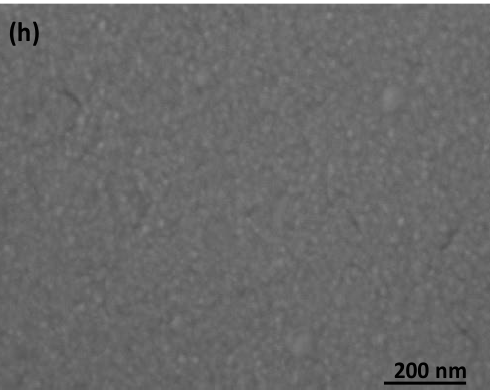
Figure 3. ( a ) XRD analysis for Sb 2 Se 3 thin films, ( b ) XRD analysis for CdS (inset: absorbance vs. wavelength spectra), and ( c ) band gap of Sb 2 Se 3 thin films at room temperature. Raman analysis for ( d ) Sb 2 Se 3 thin films and ( e ) CdS thin films. ( f ) FE-SEM analysis for Sb 2 Se 3 thin films, ( g ) EDAX spectroscopy for Sb 2 Se 3 thin films, and ( h ) FE-SEM analysis for CdS thin films.